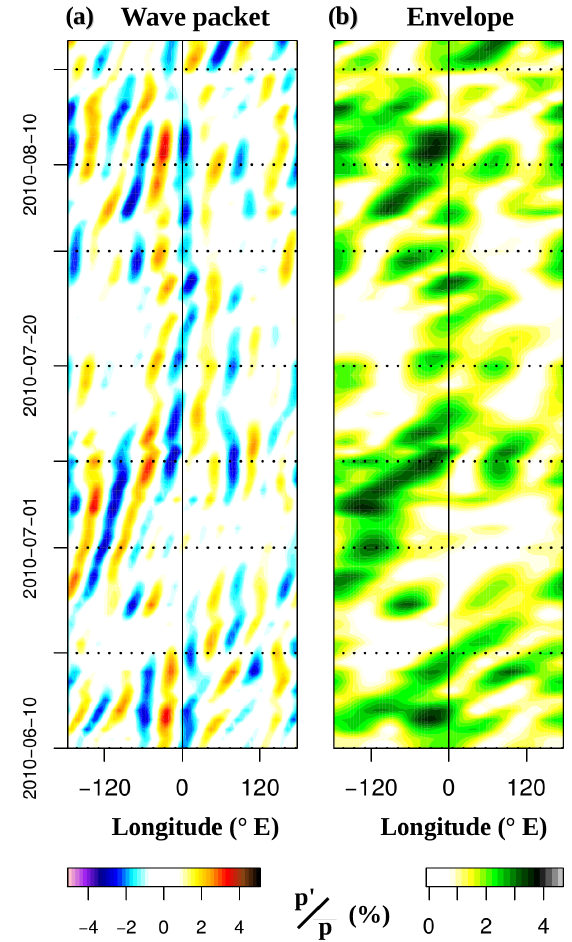
Figure 8. (a) Hovmöller diagram of RWP pressure anomalies (w4– 8) at zonal-mean tropopause level for June–July–August 2010, aver- aged for 50–60 ◦ N. (b) Corresponding envelope of the RWP anoma- lies in (a) . Horizontal dotted lines mark the 1st, 10th and 20th days of the